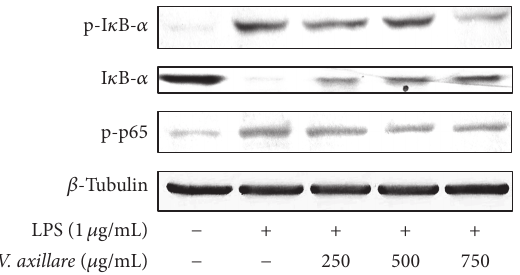
Figure 5: V. axillare inhibits LPS-induced phosphorylation of p65 and prevented I 𝜅 B- 𝛼 degradation in RAW264.7 macrophages. Cells werepretreatedwith V.axillare for1 hbeforeincubationwithLPSfor 30 min. Levels of phosphorylated p65 and total and phosphorylated I 𝜅 B- 𝛼 were determined by western blot analysis. 𝛽 -Tubulin was used as a loading